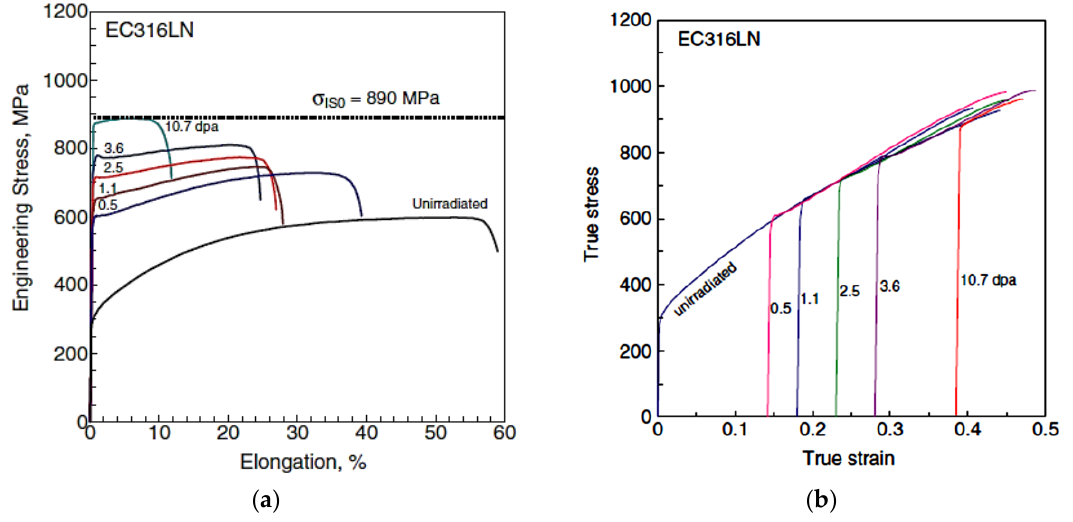
Figure 7. ( a ) Engineering stress–strain curves and ( b ) true stress—true strain curves for EC316LN stainless steel irradiated at 60–150 °C and tested at room temperature. The true stress—true strain curves of irradiated specimens are shifted in the positive direction by strains of 0.14, 0.18, 0.23, 0.28, and 0.385, respectively, to superimpose on the curve of unirradiated material. Irradiation-induced increases in yield stress were 305, 358, 421, 485, and 587 MPa, respectively. Note load drops at the yield point for the irradiated specimens. Modified from [25].